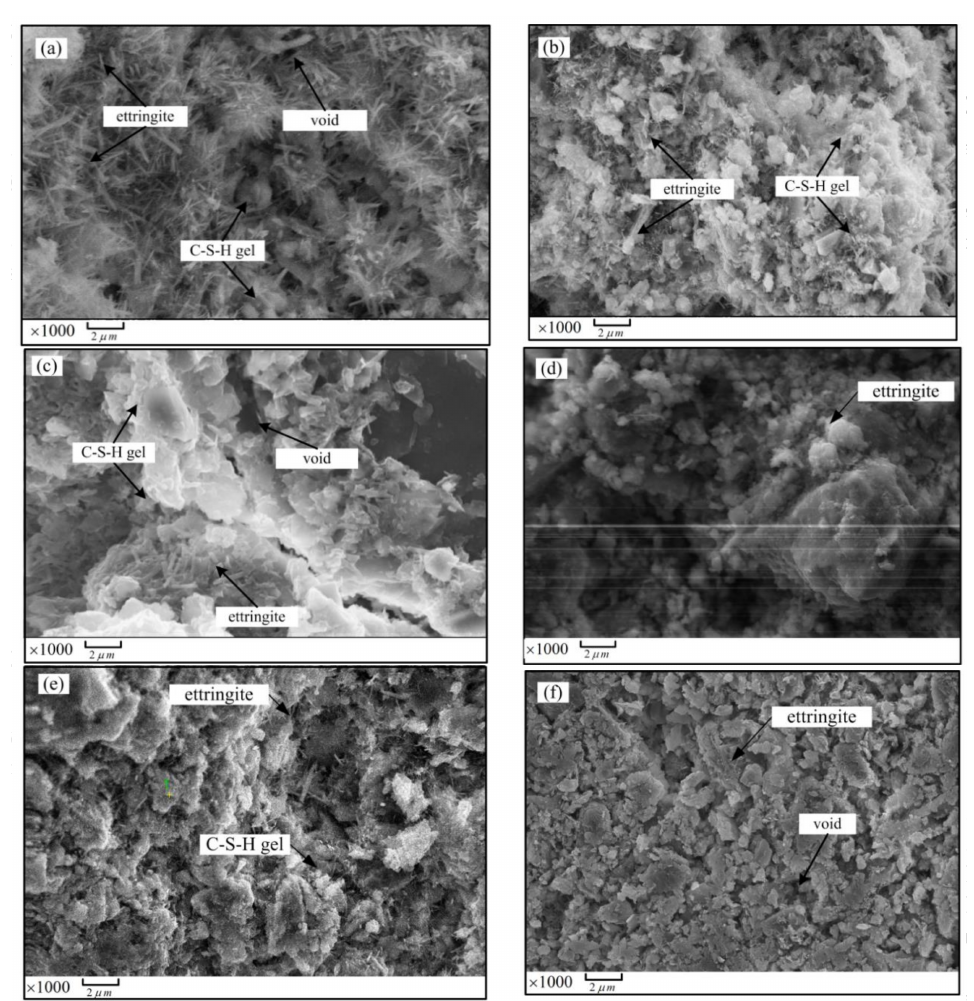
Figure 7. Influence of curing time on the microstructure evolution of the CTB produced from a mix with 25% of Portland cement tailings and 70% solid content at curing times of ( a ) 3 days; ( b ) 7 days; ( c ) 28 days; ( d ) 56 days; ( e ) 90days at 1000 × magnification; and ( f ) 90 days at 1000 ×